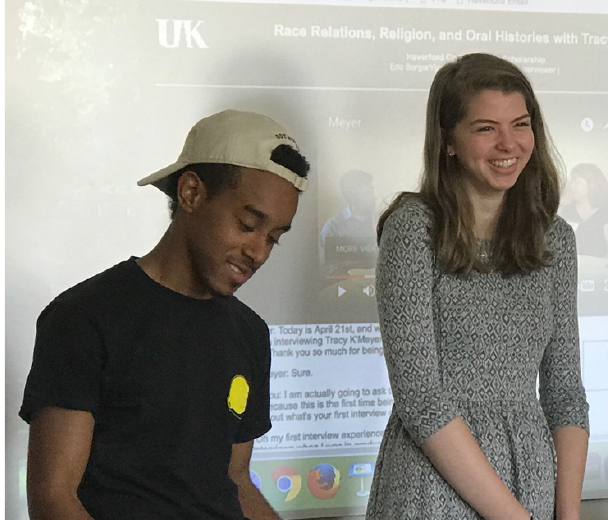
FIGURE 3. (LEFT TO RIGHT): RUDOLF HERNANDEZ AND ALYSSA KERPER PRESENT ON THE LAST DAY OF CLASS ABOUT THEIR EXPERIENCES WITH THE ORAL HISTORIES